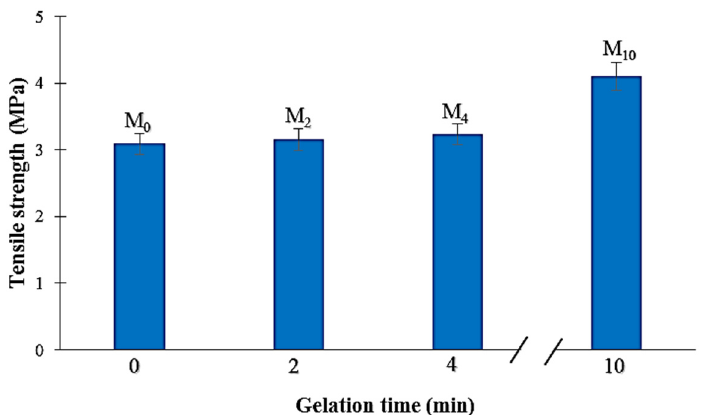
Figure 9. Tensile strength of the PA6 membranes with different gelation time.